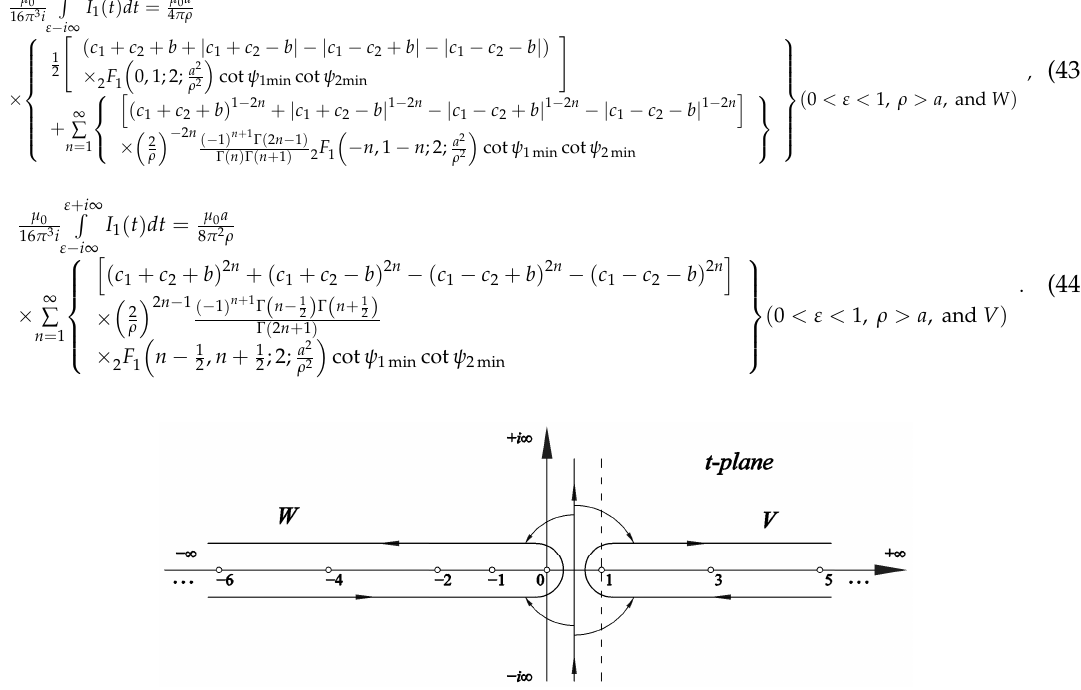
(cid:82) ε + i ∞ I 1 ( t ) dt and the poles on the real μ ε + ∞ ε − i ∞ ( ) 0 16 π 3 i i  and the poles on the real axis. I t dt π 13 16 ε − ∞ i i